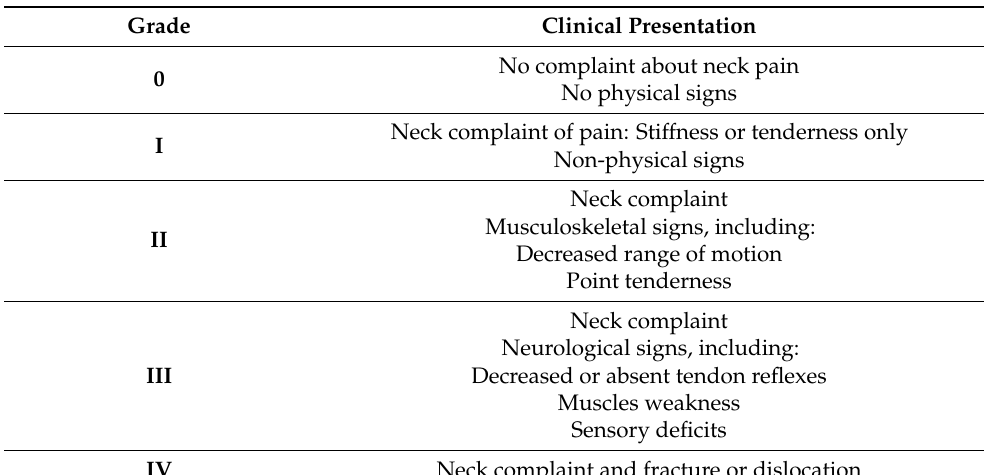
Table 1. Quebec Task Force whiplash-associated disorders (WAD)